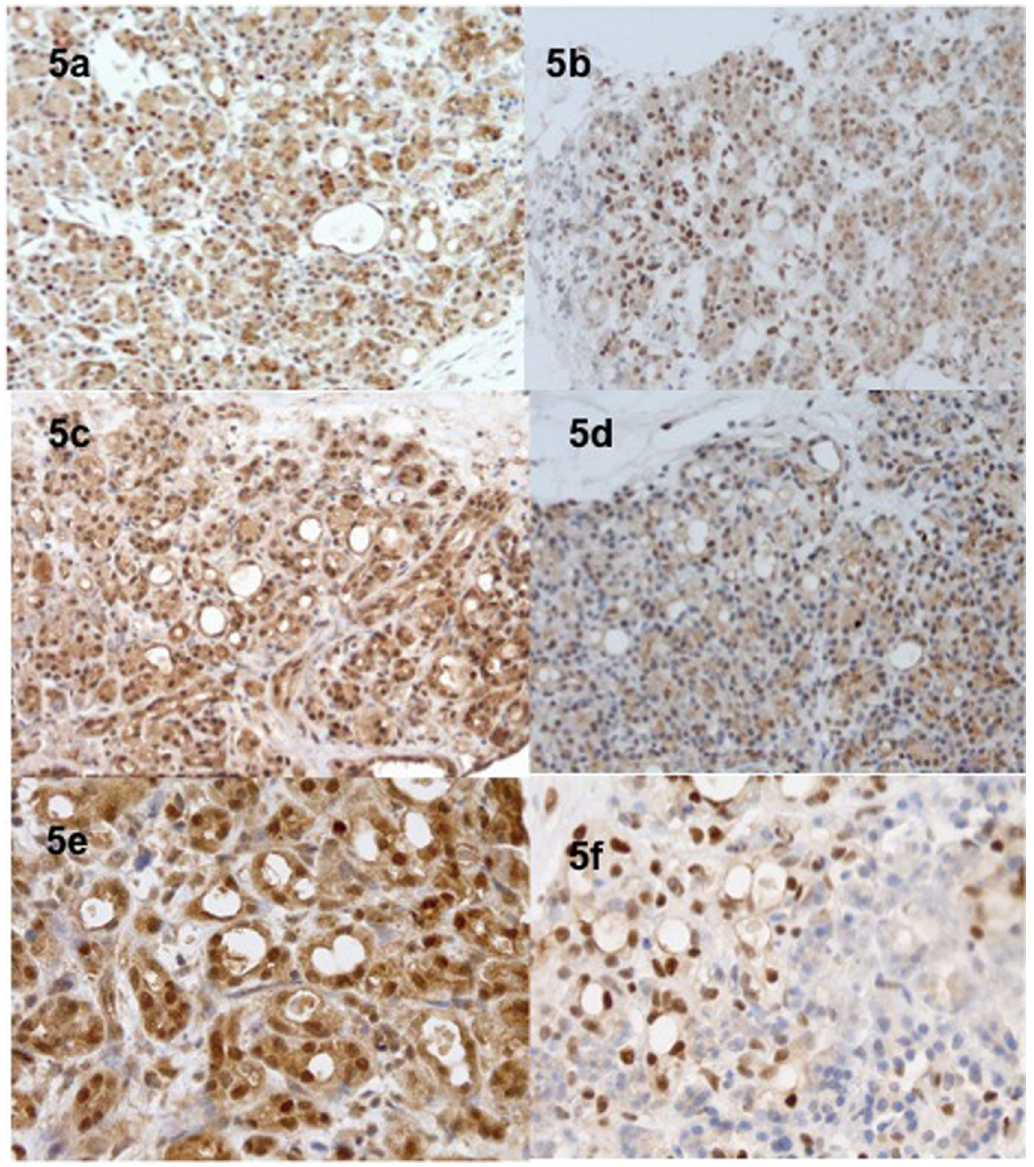
Figure 5. Expression of the Hif-1α in hyperoxic conditions (H24, 5a; H48, 5c and H72, 5e) and in normoxic conditions (H24, 5b; H48, 5d and H72, 5f). Hyperoxia conditions promoted a more intense expression of the hypoxia